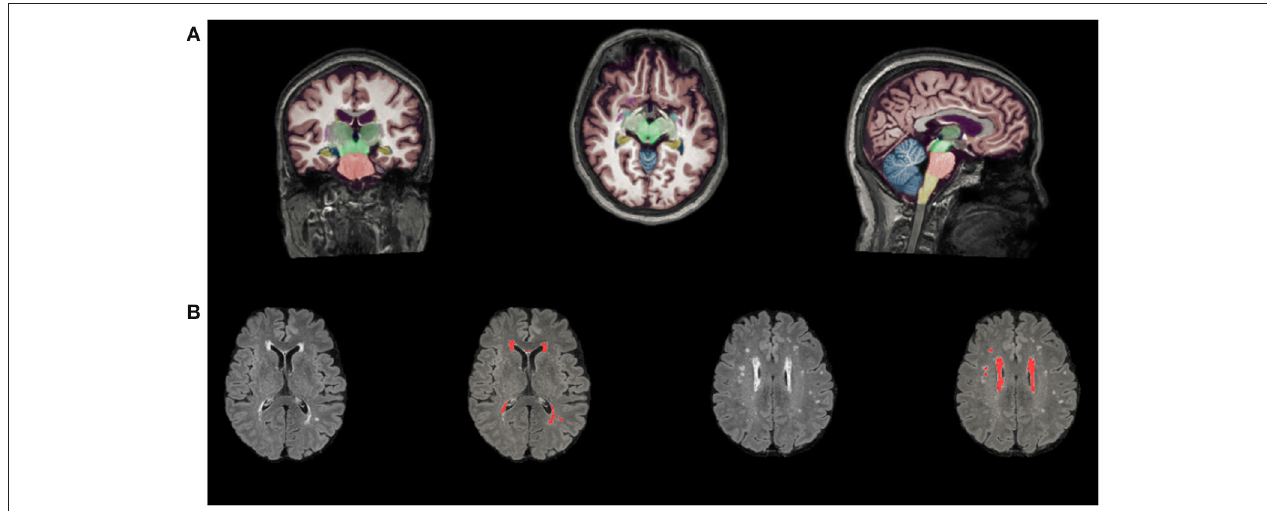
FIGURE 1 | Automated segmentation and quantitative using AccuBrain TM . (A) Volume segmentation and quantification of anatomical regions based on T1-weighted MRI scans. (B) WMH volume segmentation and quantification were based on FLAIR images. WMH, white matter